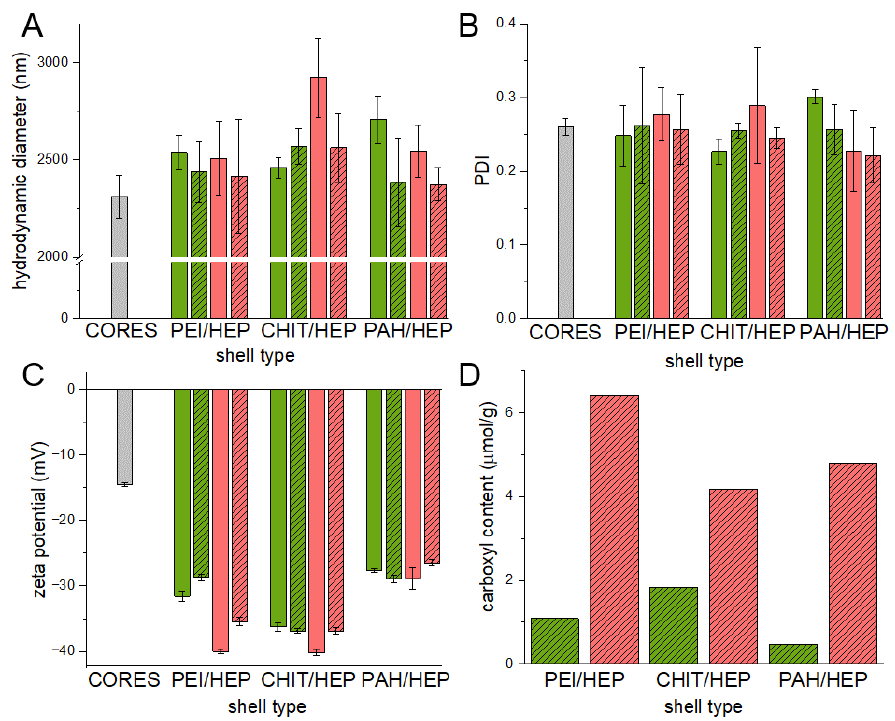
Figure 8. ( A ) Hydrodynamic diameter, ( B ) diameter polydispersity index, ( C ) ζ potential and ( D ) surface carboxyl content of core-shell particles with crosslinked (dashed) and non-crosslinked (plain) bilayers (green) and tetralayers (pink) of three coating variants on AA -loaded PCL cores.